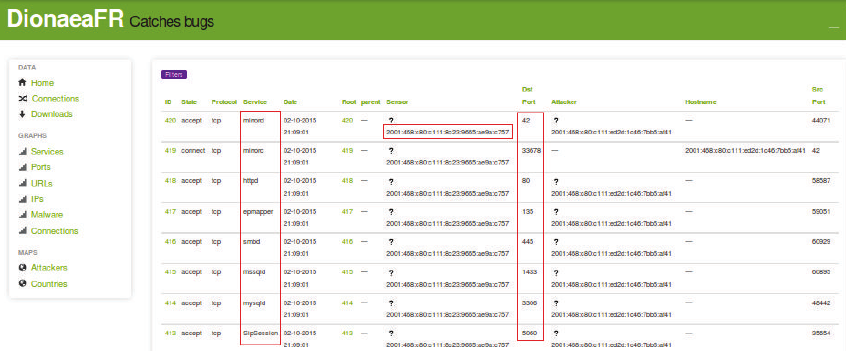
Figure 10: DionaeaFR console showing deployed honeypot connection